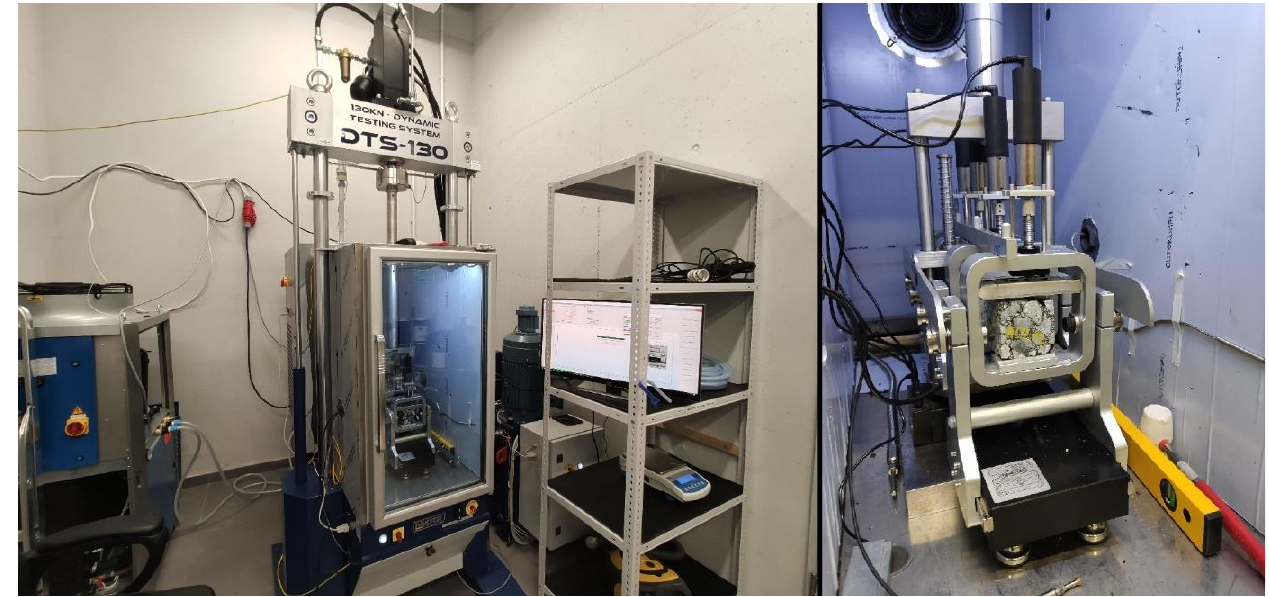
Figure 1. Hydraulic test machine.